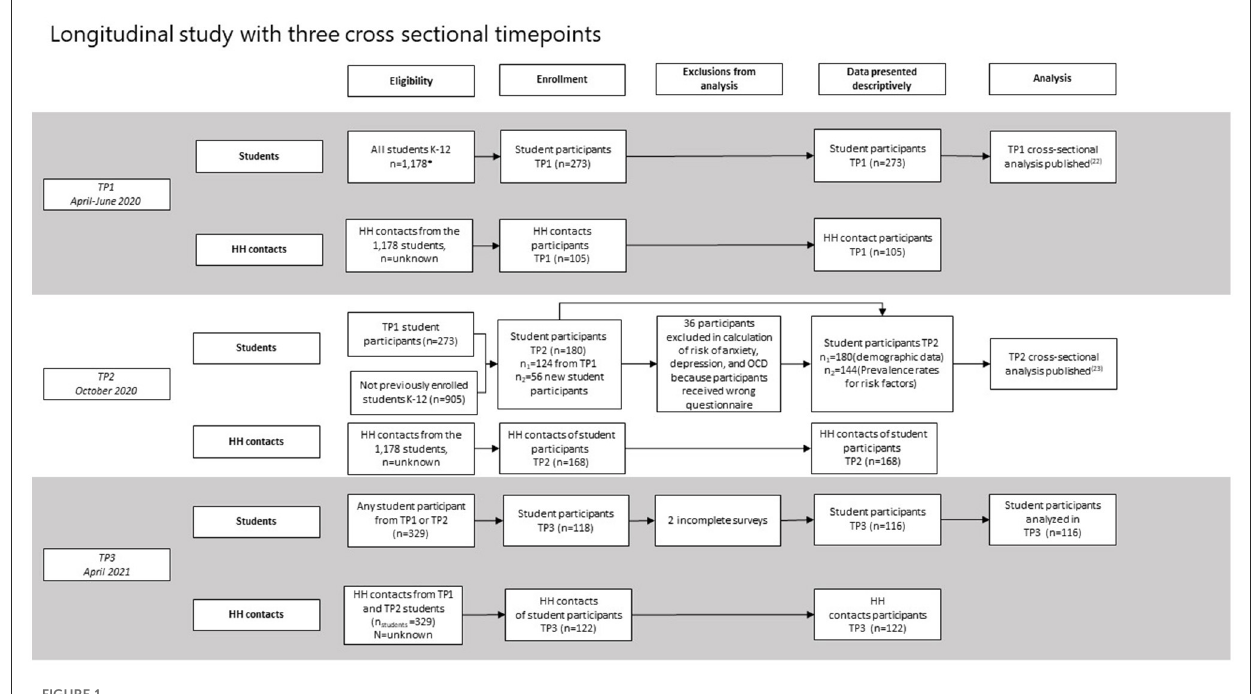
FIGURE1 Study design, eligibility, and